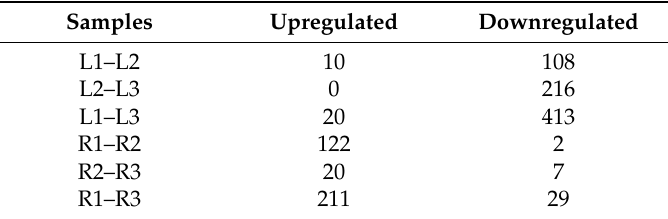
Table 1. Numbers of differently expressed proteins during drought stress. The “upregulated” row indicates the number of upregulated proteins in posterior samples compared with anterior samples. The “downregulated” row indicates the number of downregulated proteins in posterior samples compared with anterior samples.